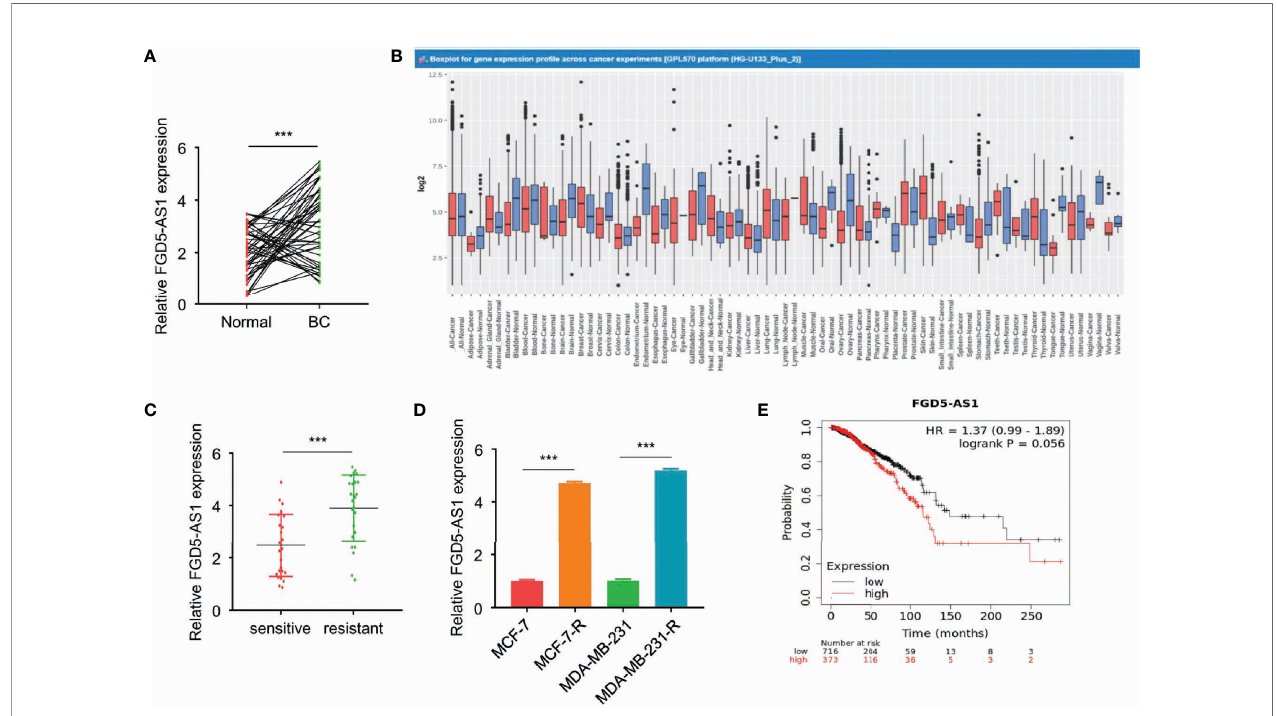
FIGURE 1 | FGD5-AS1 is highly expressed in radioresistant BC tissues and cell lines. (A) The expression of FGD5-AS1 in BC tissues (n=50) and corresponding adjacent normal tissues (n=50) via qRT-PCR assays. (B) GENT2 database showed the signi fi cant upregulation of FGD5-AS1 in BC tissues compared with normal tissues (breast- normal) (P < 0.001); (C) Examining the expression of FGD5-AS1 in the radio-sensitive group and radio-resistant via qRT-PCR assays. As indicated, FGD5-AS1 expression was signi fi cantly increased in the radio-resistant group than the radio-sensitive group. (D) The expression of FGD5-AS1 in the radio-resistant BC cell lines. As indicated, the expression level of FGD5-AS1 was signi fi cantly increased in the radio-resistant BC cells compared to that in their parental cells. (E) Using the KM plotter database, to show that higher FGD5-AS1 expression was correlated with worse survival in BC patients. Intra-group comparison ***p < 0.001.